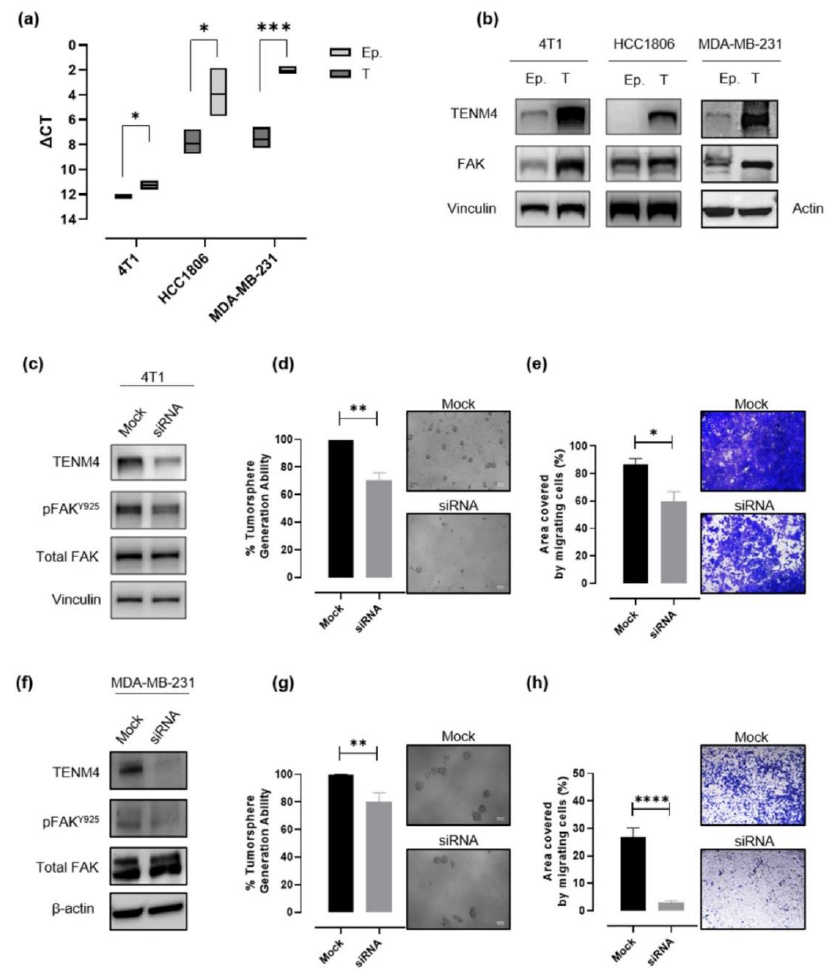
Figure 4. Evaluation of the role of TENM4 in tumorspheres. ( a ) Semi-quantitative RT-PCR. Boxes represent the ΔCt (i.e., the difference between the Ct of TENM4 and the Ct of the internal control gene GADPH), comparing epithelial (Ep.) and tumorsphere-derived (T) cells. The inner line of the box corresponds to the mean value, upper and lower edges correspond to higher and lower value, respectively. ( b ) Immunoblot of TENM4, total FAK and loading control protein, vinculin or β-actin, comparing 4T1, HCC1806 and MDA-MB-231 epithelial (Ep.) and tumorsphere-derived (T) cells. ( c , f ) Immunoblot of TENM4, total FAK, FAK phosphorylated at Y925 and loading control protein, vinculin or β-actin, comparing 4T1 or MDA-MB-231 epithelial cells, respectively, treated with a pool of TENM4-specific siRNA (siRNA) or a pool of non-targeting siRNA (mock). ( d , g ) Histograms showing the sphere-generation ability and representative pictures of the formed tumorspheres after TENM4 silencing in 4T1 and MDA-MB-231 cells, respectively. The mean values in the mock siRNA-treated condition were used as reference and considered to be 100%. Values of TENM4 silenced cells represent the % of the tumorsphere forming ability respect the mean value of the mock siRNA-treated cells. White scale bar: 100 µm. ( e , h ) Effect of TENM4 silencing on 4T1 and MDA-MB-231 cell migratory ability, assessed by using the Transwell migration assay. Histograms showing the mean ± SEM of the percentage of the area covered by migrating siRNA and mock cells and representative pictures of crystal violet-stained migrating cells are reported for 4T1 and MDA-MB-231 cells, respectively. Statistical analysis was carried out with Student’s t test: * p < 0.05; ** p ≤ 0.006; *** p < 0.001; **** p < 0.0001.